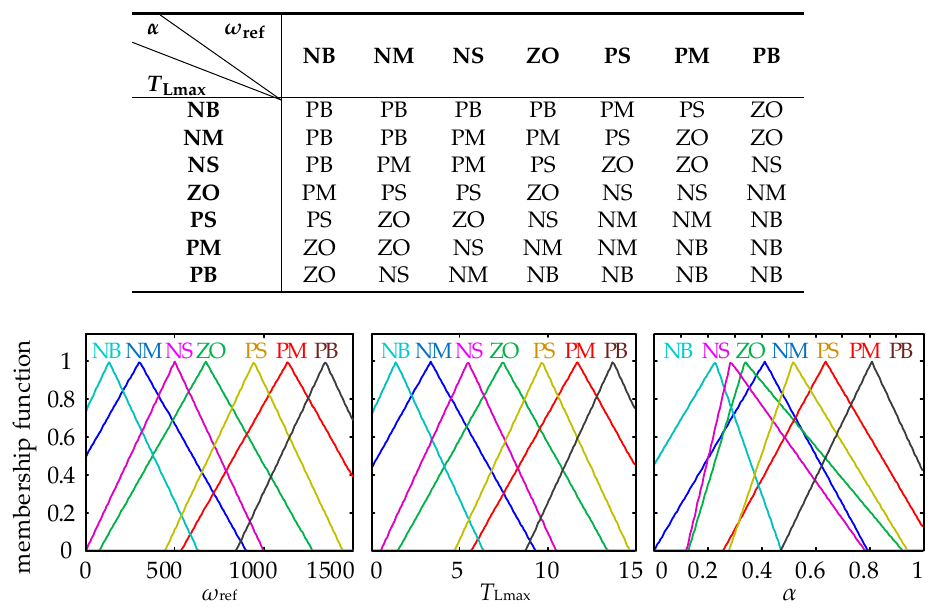
Figure 6. Fuzzy input/output membership function of the fuzzy controller.